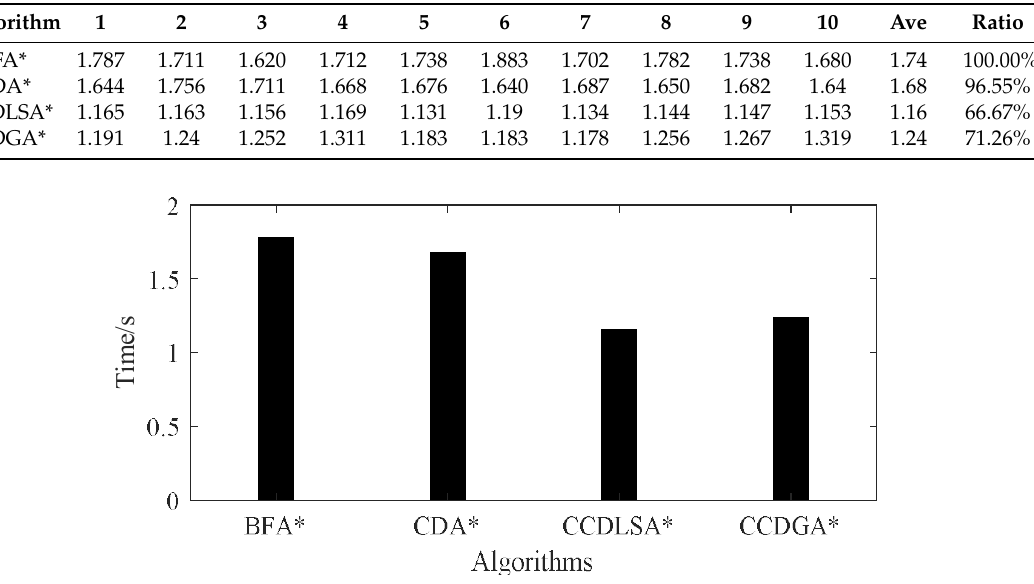
Table 5. Single Diagnosis Time(s) for BFA*, CDA*, CCDLSA* and CCDGA*.